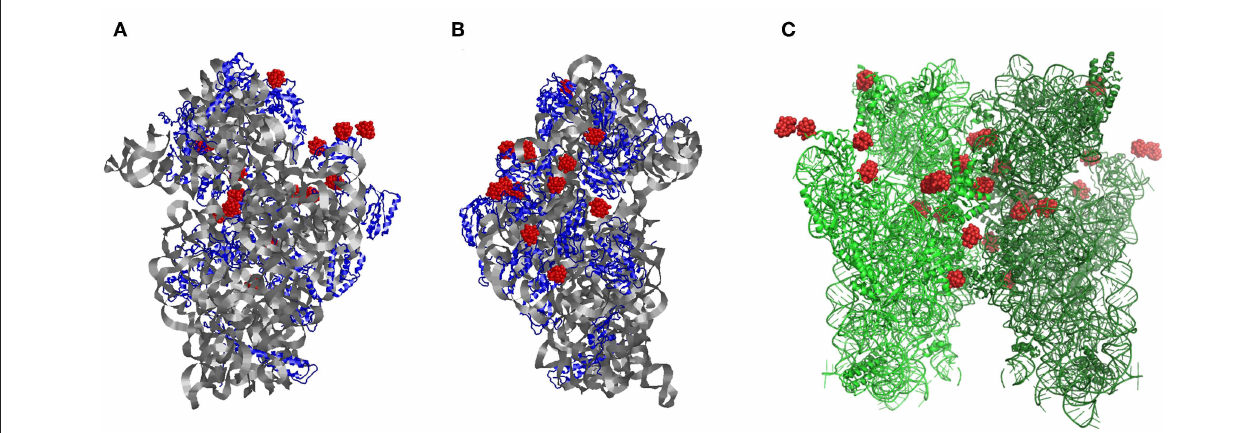
FIGURE 1 | The structure of the small ribosomal subunit from Thermus thermophilus (T30S) from the (A) front and (B) side, respectively. (C) Symmetry-generated dimeric form of two ribosomal small subunit structure within their crystals showing each of the P 2 W 18 sites (red). Modified with permission from Bashan and Yonath (2008).